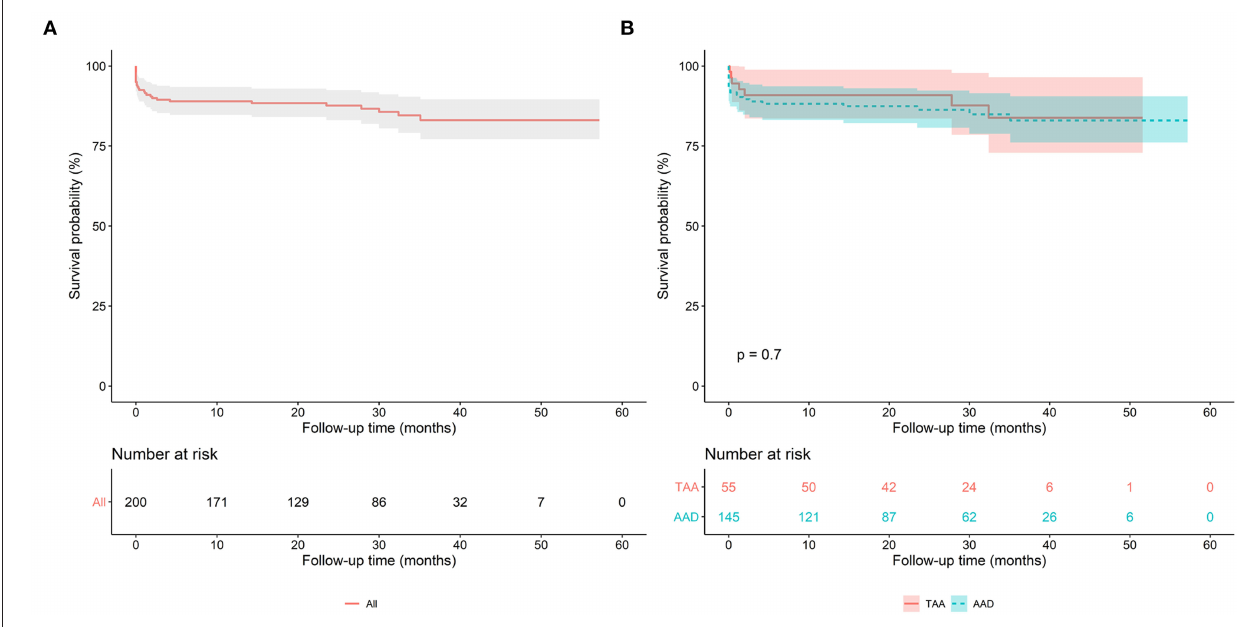
FIGURE 2 | (A) Kaplan-Meier analysis of the overall population after the FET technique. (B) Kaplan-Meier analysis of the acute aortic dissection (AAD) group and the thoracic aortic aneurysm (TAA) group.